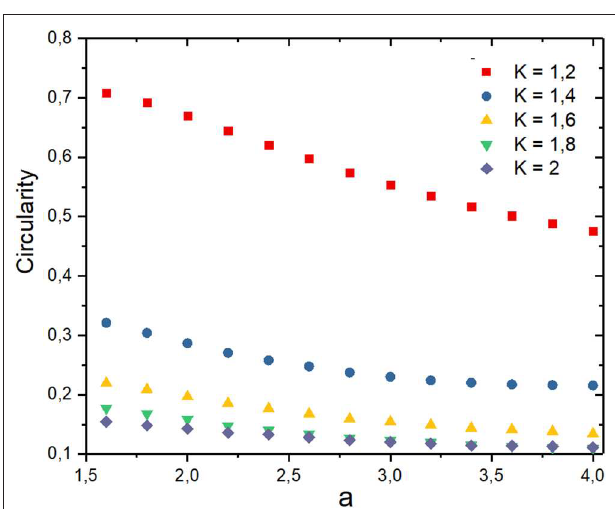
FIGURE 4 | Circularity of dendrites. This figure shows the Circularity of dendrites at time t 0.1 for nuclei grown on substrates of different radii a , and = for different values of the constant K (error bars are of the order of symbol size and omitted for clarity). Note that for smaller (higher curvature) the nuclei become less